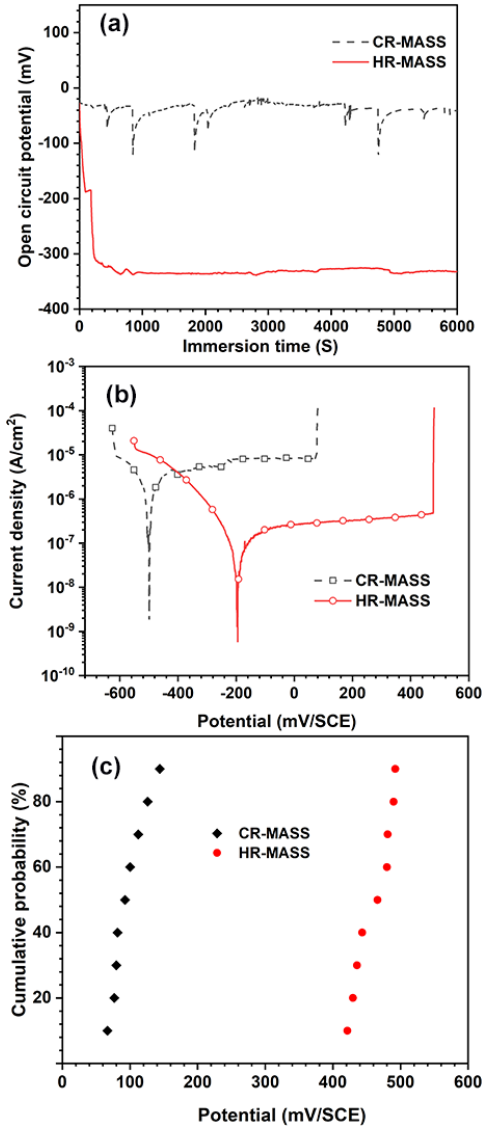
Figure 5. Results of electrochemical measurements: ( a ) open circuit potentials (OCPs) of the experi- mental MASS, ( b ) potentiodynamic polarization curves of the experimental MASS and ( c ) the cu- mulative probability distribution of pitting potentials (E pit ) of the experimental MASS. All tests were conducted in 3.5 wt.% NaCl aqueous solution at ambient temperature (~25 °C). The potentiodynamic polarization (PDP) curves of the experimental MASS are pre- sented in Figure 5b, where the pitting potentials (E pit ) of the samples were recorded when the surface current density reached 0.1 mA/cm 2 . It turns out that the HR- and CR-MASS all exhibited clear passive regions before the applied potential exceeded E pit , where the current density of the sample surface remained almost a constant passive current density ( i pass ) value in the increasing in the polarizing potential. Figure 5c shows the cumulative distribution of E pit for both HR- and CR-MASS based on nine groups of PDP results, in which the E pit of HR-MASS is nearly 480 mV (vs. SCE), much higher than that of the CR- MASS (approximately 40 mV (vs. SCE)). In addition, the i pass of the HR-MASS is 3.74 μA/cm 2 , smaller than that of the cold rolled samples (8.37 μA/cm 2 , shown in Table 2). Since the i pass values were measured when the polarized potential reached the passive region,